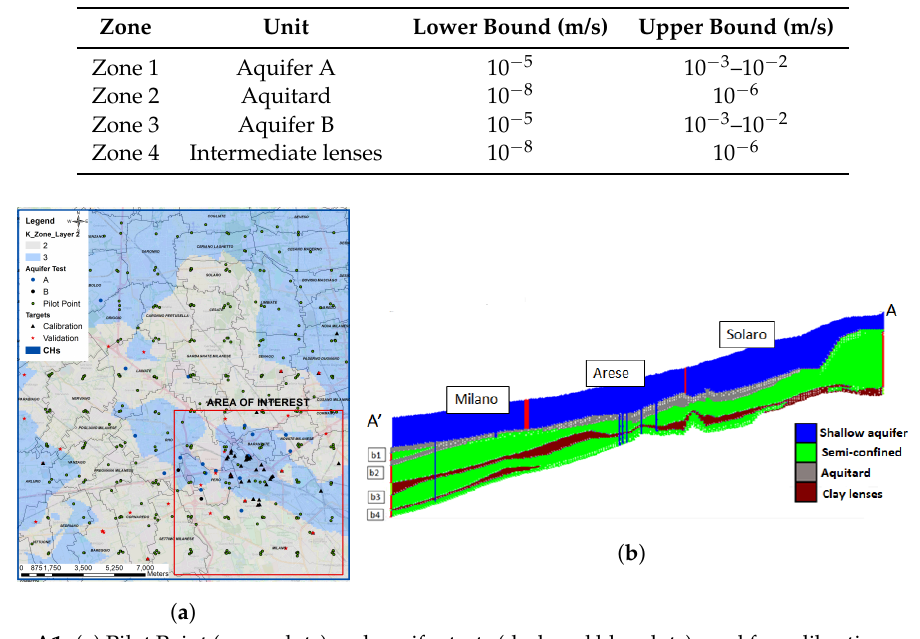
Figure A1. ( a ) Pilot Point (green dots) and aquifer tests (dark and blue dots) used for calibration process with observation and validation head targets. The K-zone represents in brown the discontinuous aquitard whereas the light blue is the Aquifer A in layer 2, ( b ) cross-section in Figure A1b represents the vertical discretization of the numerical model: in blue the Aquifer A and in green the Aquifer